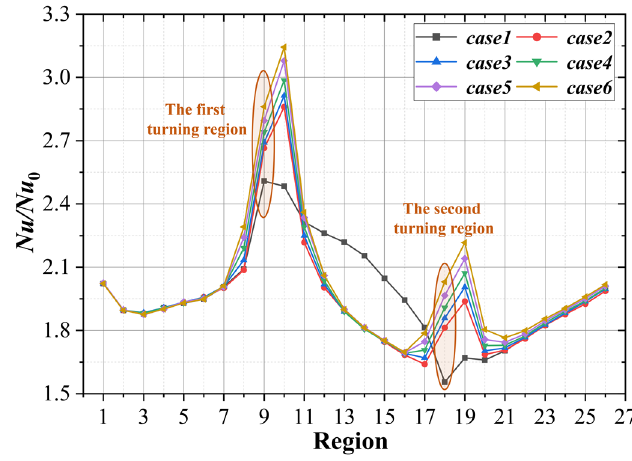
Figure 17. The wall Nu/Nu 0 of RS LE , Ro = 0.4.